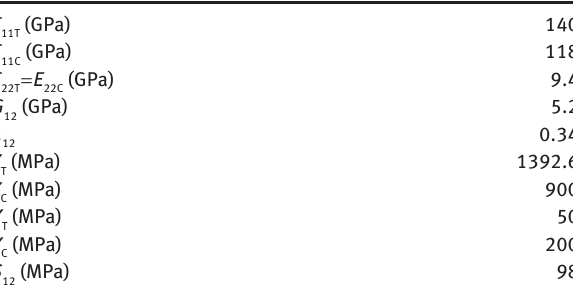
Table 5: Mechanical properties of the